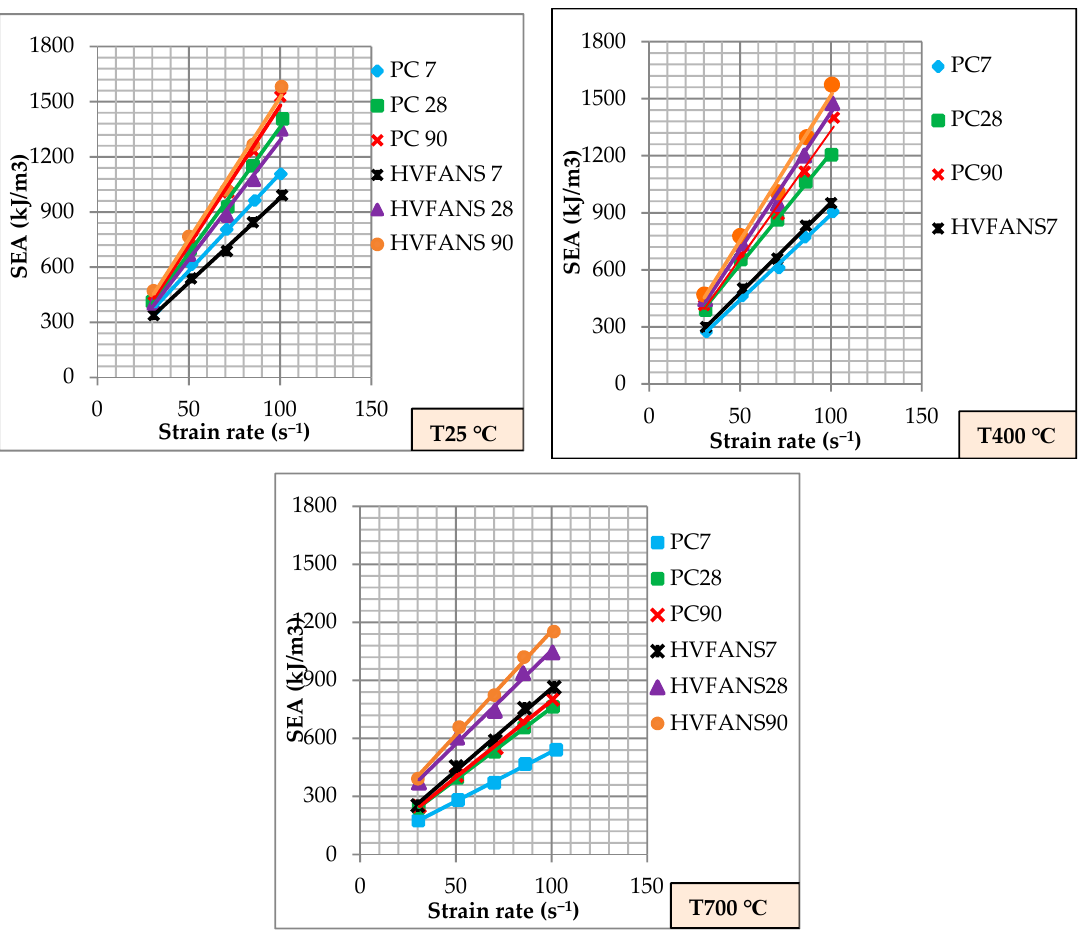
Figure 8. E ff ect of curing age on the toughness of concrete specimens at di ff erent temperatures and Figure 8. Effect of curing age on the toughness of concrete specimens at different temperatures and strain strain rates.